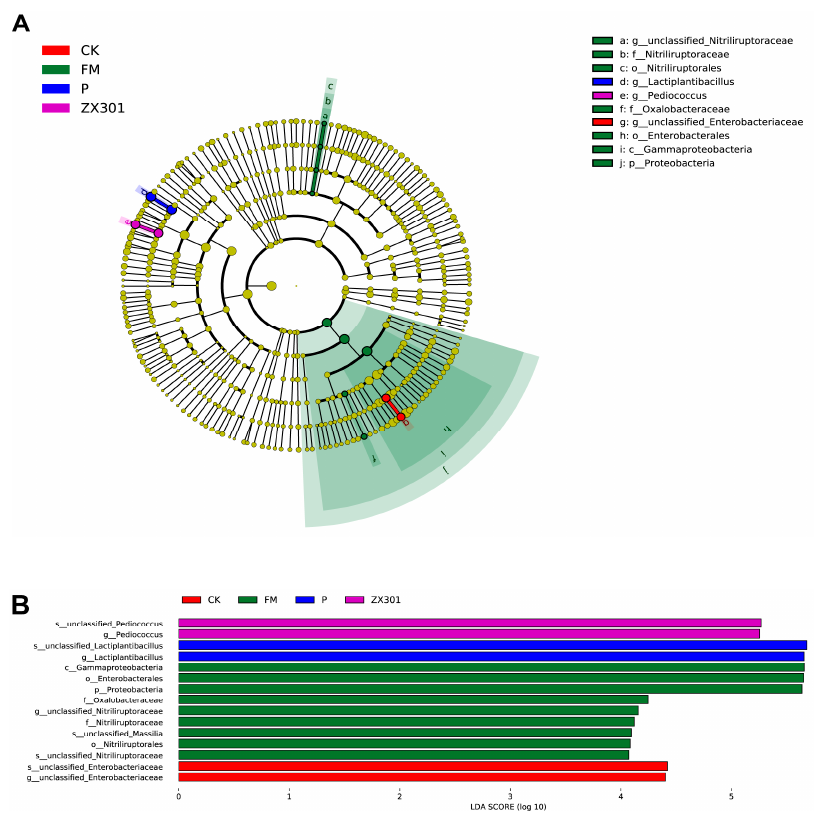
Figure 3. Linear discrimination analysis (LDA) coupled with effect size (LEfSe) analysis of the microbial community of the FM and Stipa grandis on 60 days of ensiling ( n = 3): ( A ) Cladogram showing microbial species with significant differences between the FM and Stipa grandis on 60 days of ensiling. Red, green, purple, and blue represent different groups. Species classification at the phylum, class, order, family, and genus level are displayed from inner to outer layers. The red, green, purple, and blue nodes represent microbial species in the phylogenetic tree that play important roles in the CK, FM, ZX301, and P groups, respectively. Yellow nodes represent no significant difference between species. ( B ) Significantly different species with an LDA score greater than the estimated value (default score = 4). The length of the histogram represents the LDA score of different species in the FM and Stipa grandis on 60 days of ensiling. FM, fresh matter; CK, control group; ZX301, pediococcus pentosaceus -treated group; YX34, lactobacillus planturum -treated group; P, a commercial inoculant-treated group containing lactobacillus plantarum